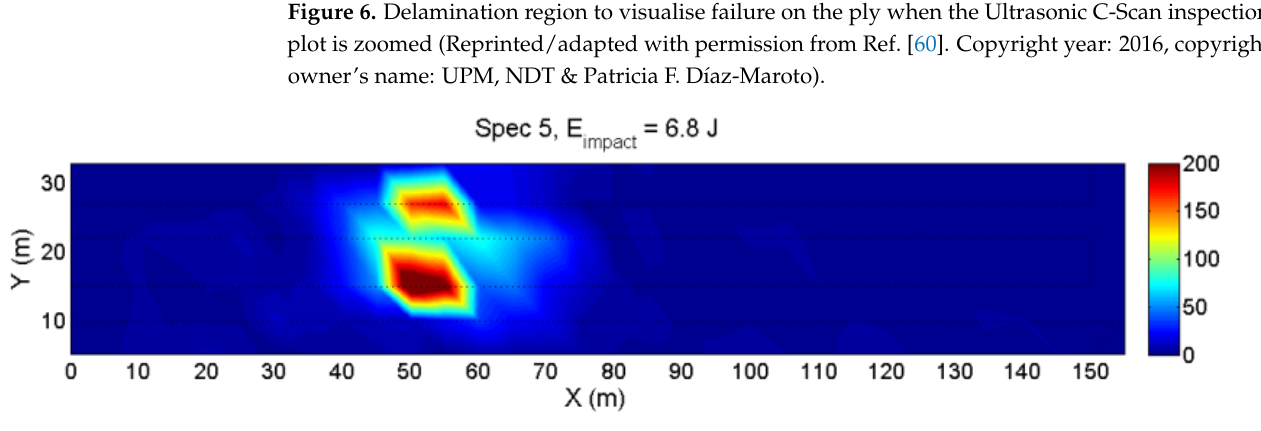
Figure 7. The result after the impact of 6.8 J shows the strain map (Reprinted/adapted with per- mission from Ref. [60]. Copyright year: 2016, copyright owner’s name: UPM, NDT & Patricia F. Díaz-Maroto).